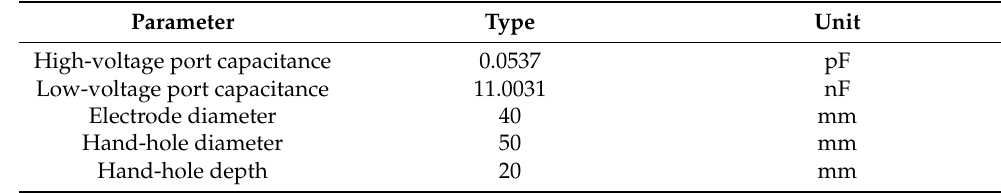
Table 1. The parameters of port-hole type capacitive divider sensor.